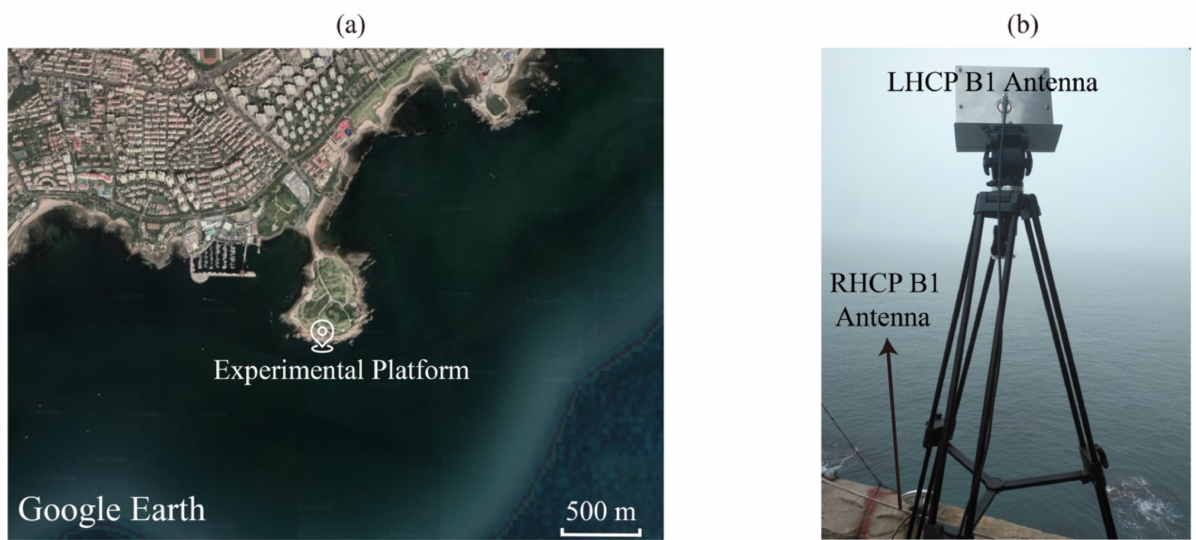
Figure 5. GNSS-R experiment setup at Qingdao, China. ( a ) Aerial image (Google Earth) of the experimental site. ( b ) Photo- graph of the side-looking LHCP antenna and RHCP